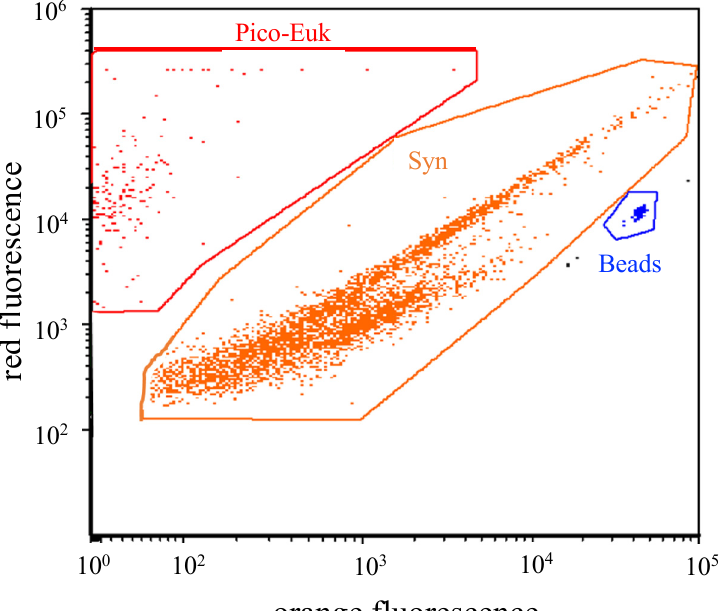
Figure 1. Resolution of picophytoplankton cell groups by flow cytometry. Typical red (chlorophyll a ) versus orange fluorescence (phycoerythrin) cytograms exhibiting the resolution of Synechococcus spp. (Syn) and picoeukaryotes (Pico-Euk).